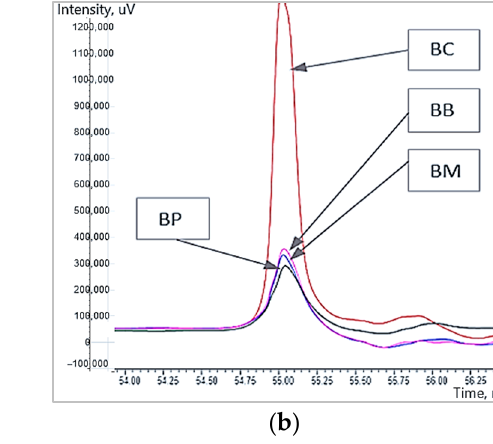
Figure 8. Peak area of HPLC chromatogram of wheat bran samples gliadin extract after incubation: ( a ) gliadin degradation products; ( b ) γ -gliadins (BC, control bran sample; BB, bran treated with bromelain; BP, bran treated with papain; BM, bran treated with a combination of bromelain and papain).